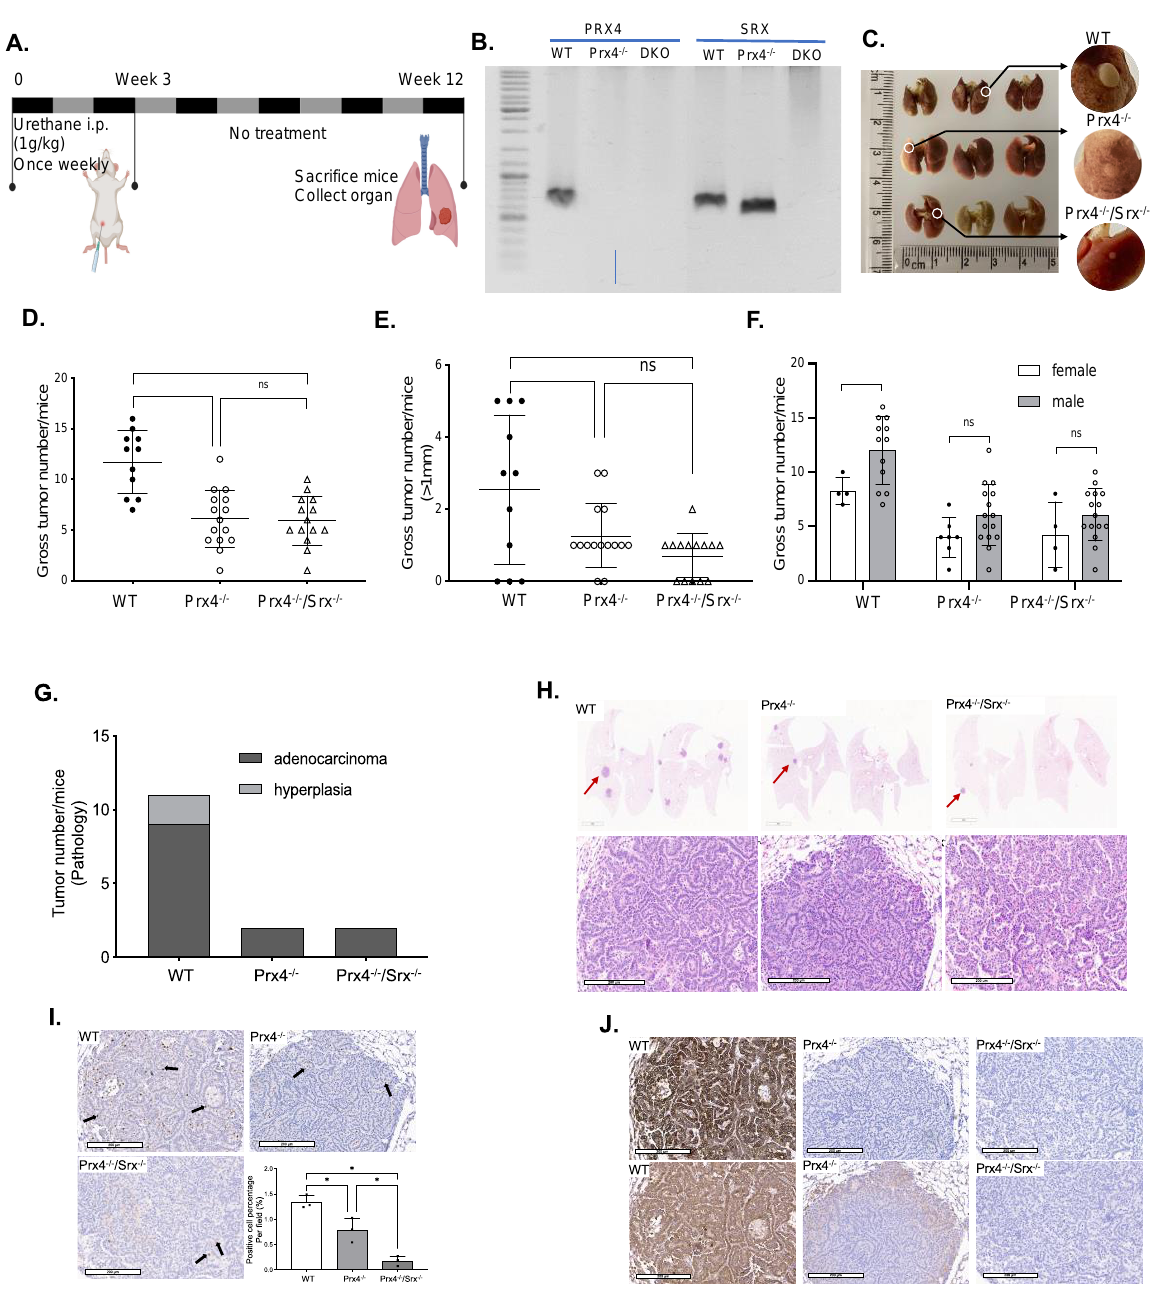
Figure 1. Loss of Prx4 or Srx/Prx4 suppresses tumor formation and cell proliferation in the urethane- induced lung adenocarcinoma mouse model. ( A ) Schematic illustration of the methodology for 12-week urethane-induced lung tumorigenesis in mice. ( B ) Genotype verification. ( C ) Lung gross images with zoom-in of tumors on the surface. ( D ) Comparing the average tumor number of each mouse with three genotypes (>0.2 mm). ( E ) Comparing the average tumor number of each mouse with three genotypes (>1 mm). ( F ) Comparing the average tumor number of each mouse with gender difference for the three genotypes (>0.2 mm). ( G ) Pathologic diagnosis of tumors for the three genotypes based on H&E histology. ( H ) H&E staining of lung tumors microscopic image for the three genotypes. Arrows identify examples of tumor. ( I ) Anti-Ki67 staining of tumor tissue from three genotypes and quantitative analysis of staining intensity. Arrows identify Ki-67 positively stained cells (brown). ( J ) Anti-Prx4 (upper) and -Srx (lower) staining of tumor tissue from three genotypes. (*, p < 0.05; ns, p >